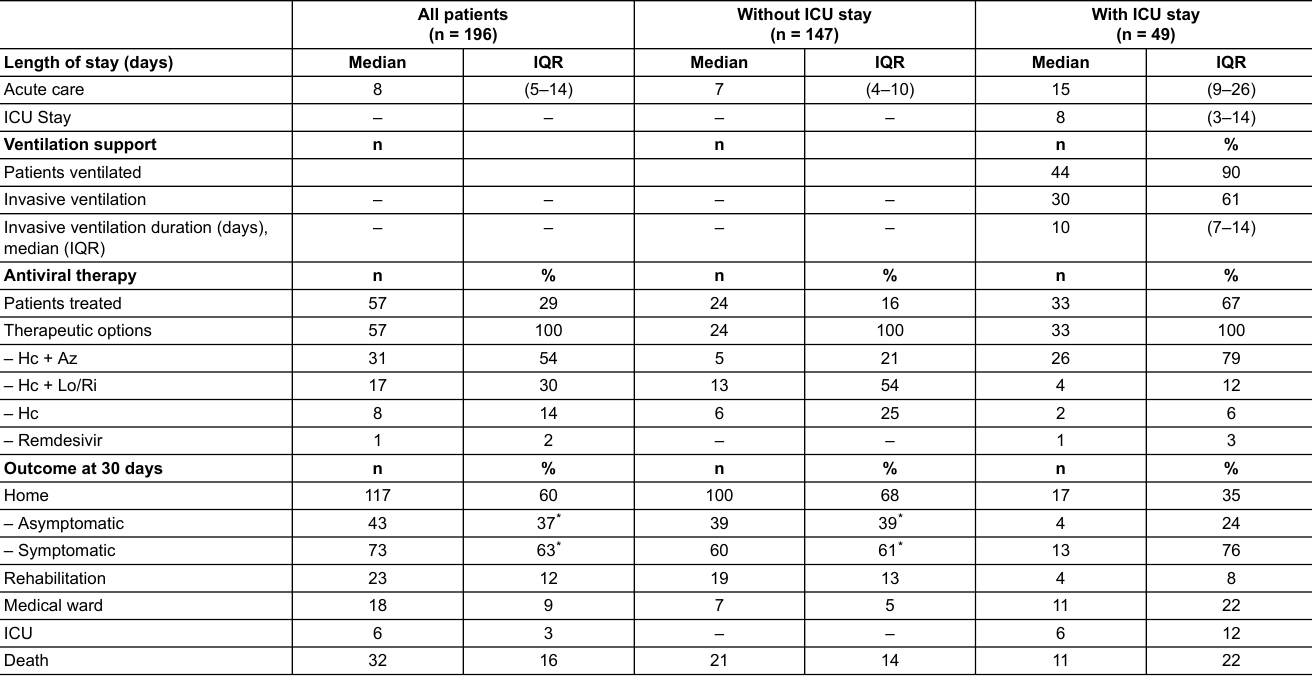
Table 2: Length of stay, invasive mechanical ventilation, antiviral therapy and follow-up at 30 days after onset of symptoms.